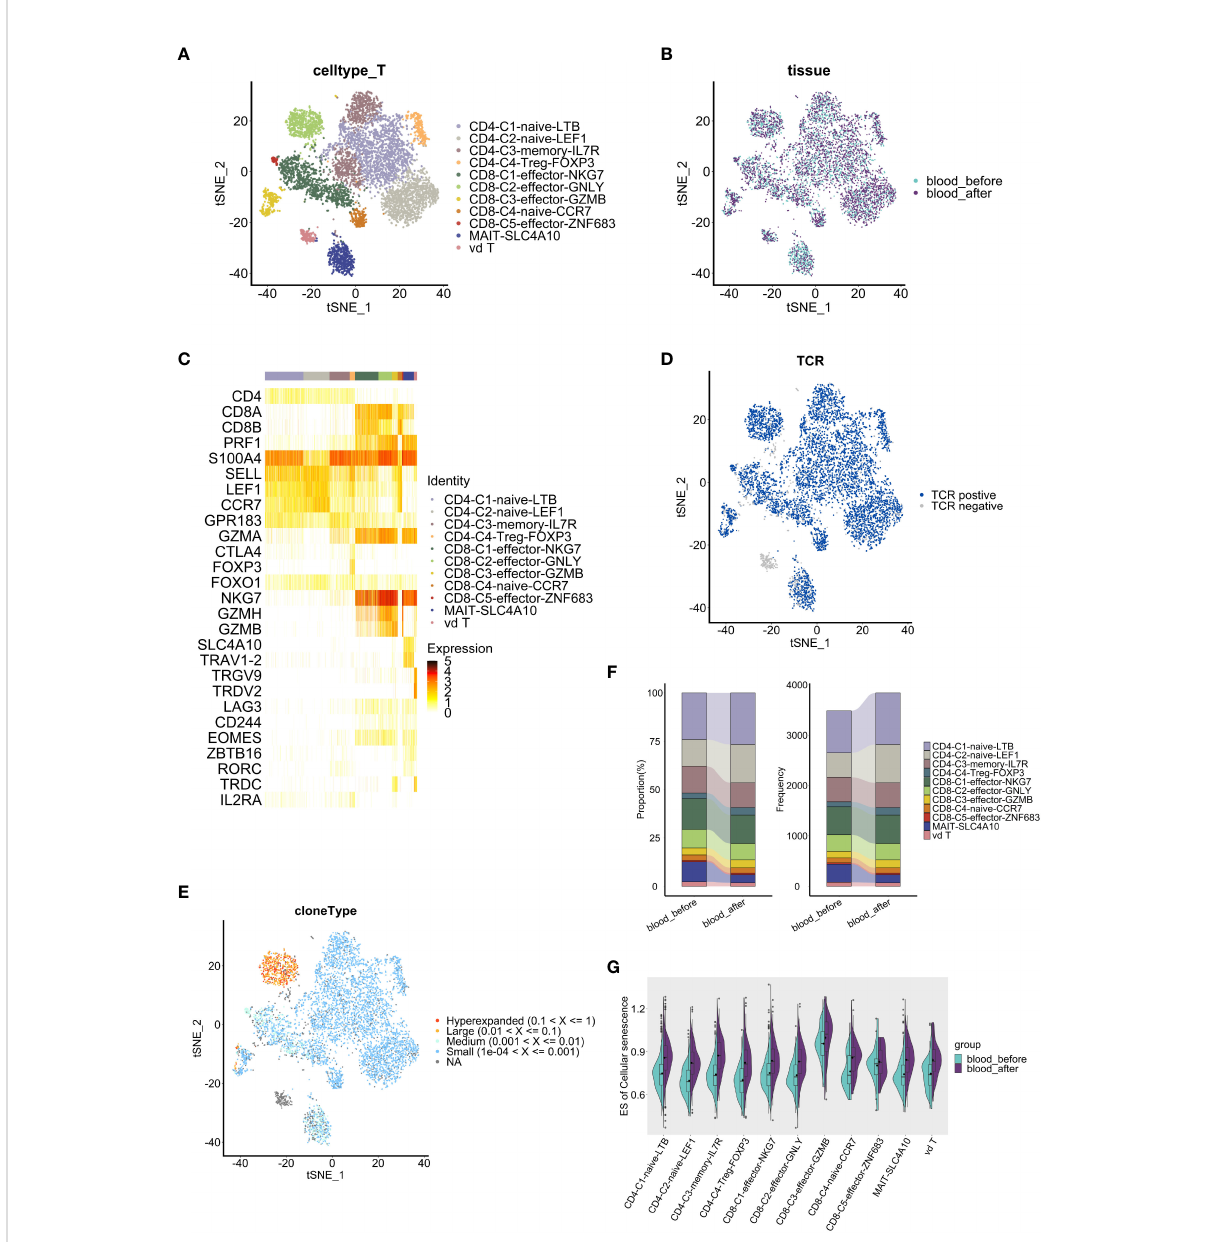
FIGURE 5 Comparative analysis of T cell features and dynamics in peripheral blood. (A, B) t-SNE visualization of T cells, colored by subclusters (A) and samples (B) . (C) Heatmap shows the expression level of marker genes in each T cell subcluster. (D) t-SNE visualization of TCRs identi fi ed in T cells. (E) t-SNE visualization of clonal expansion detected in T cells. (F) Proportion(left panel) and frequency(right panel) of T cell subclusters (y axis) in two blood samples(x axis). (G) Split violin plots show the enrichment level of cell senescence grouped by T subclusters and colored by samples. The results above are generated by comparison between samples ( blood_before, blood_after